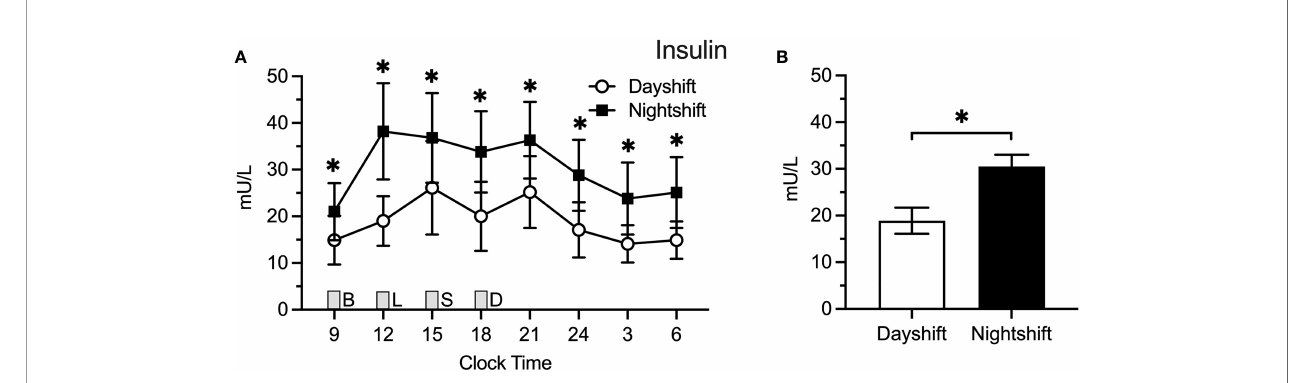
FIGURE 2 | Insulin Levels in Dayshift ( n = 8) Versus Nightshift Nurses ( n = 10). (A) Raw values ± SEMs for insulin as a function of clock time and shift type. (B) Mean 24-h values ± SEM for insulin by shift type, as derived from generalized additive models. Meals were served at 09:00 (B, breakfast), 12:00 (L, lunch), 15:00 (S, snack), and 18:00 (D, dinner) and are designated with a grey box. *p